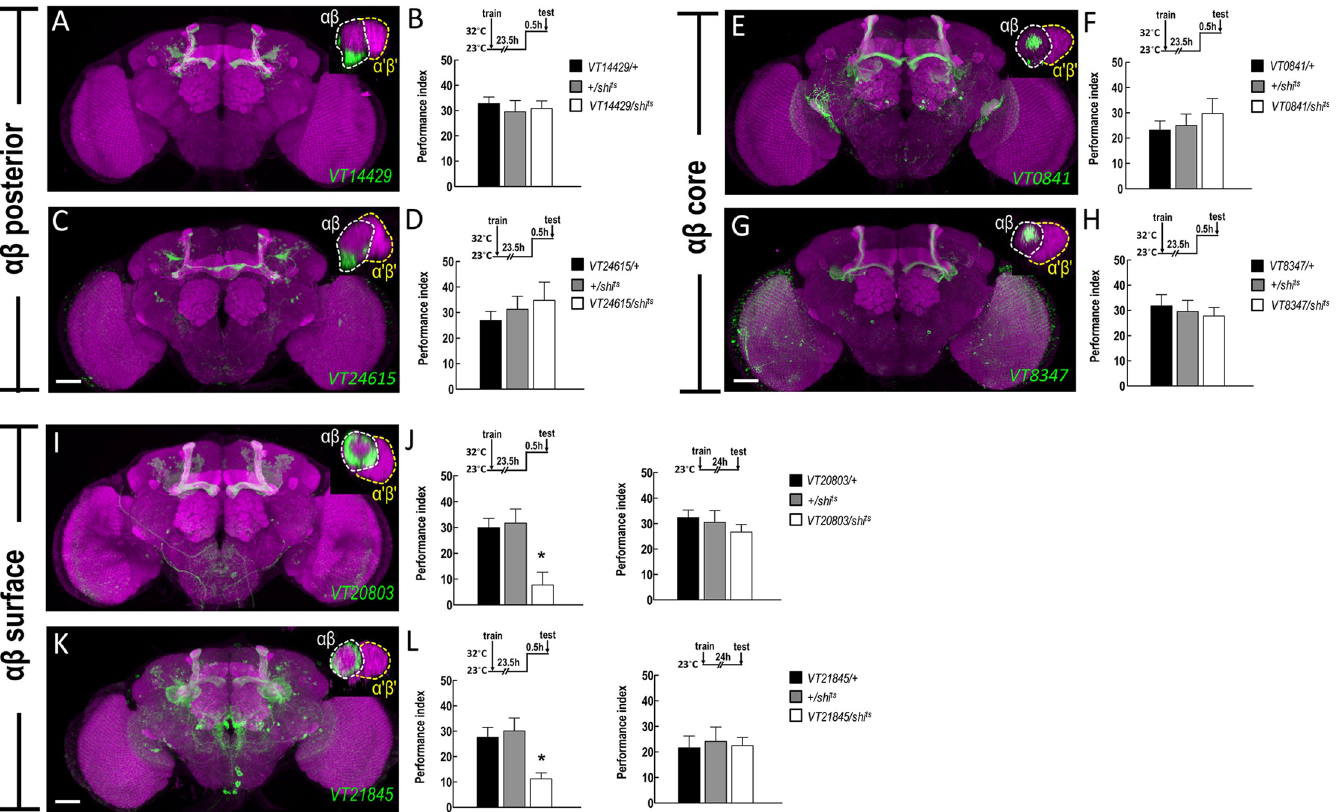
Fig 3. Retrieval of wLTM requires neurotransmission from αβ surface neurons. (A) The expression pattern of VT14429-GAL4 and the high-magnification signal from the horizontal confocal cross section of the MB vertical lobe (top right inset). (B) Blocking neurotransmission from αβ posterior neurons ( VT14429-GAL4 ) using shi ts during retrieval did not affect the 24-hour water-reward memory. Each value represents mean ± SEM (N = 8). p > 0.05; one-way ANOVA. (C) The expression pattern of VT24615-GAL4 and the high-magnification signal from the horizontal confocal cross section of the MB vertical lobe (top right inset). The brain neuropils were immunostained with anti-discs large (DLG) antibody (magenta). Scale bar represents 50 μ m. (D) Blocking neurotransmission from αβ posterior neurons ( VT24615-GAL4 ) using shi ts during retrieval did not affect the 24-hour water-reward memory. Each value represents mean ± SEM (N = 8). p > 0.05; one-way ANOVA. (E) The expression pattern of VT0841-GAL4 and the high-magnification signal from the horizontal confocal cross section of the MB vertical lobe (top right inset). (F) Blocking neurotransmission from αβ core neurons ( VT0841-GAL4 ) using shi ts during retrieval did not affect the 24-hour water-reward memory. Each value represents mean ± SEM (N = 8). p > 0.05; one-way ANOVA. (G) The expression pattern of VT8347-GAL4 and the high-magnification signal from the horizontal confocal cross section of the MB vertical lobe (top right inset). The brain neuropils were immunostained with anti-DLG antibody (magenta). Scale bar represents 50 μ m. (H) Blocking neurotransmission from αβ core neurons ( VT8347-GAL4 ) using shi ts during retrieval did not affect the 24-hour water-reward memory. Each value represents mean ± SEM (N = 8). p > 0.05; one-way ANOVA. (I) The expression pattern of VT20803-GAL4 and the high-magnification signal from the horizontal confocal cross section of the MB vertical lobe (top right inset). (J) Blocking neurotransmission from αβ surface neurons ( VT20803-GAL4 ) using shi ts during retrieval disrupted the 24-hour water-reward memory (left panel). Each value represents mean ± SEM (N = 7). � , p < 0.05; one-way ANOVA followed by Tukey’s test. The 24-hour water- reward memory was normal in VT20803-GAL4 > UAS-shi ts flies as compared to their internal control groups in 23˚C (right panel). Each value represents mean ± SEM (N = 6). p > 0.05; one-way ANOVA. (K) The expression pattern of VT21845-GAL4 and the high-magnification signal from the horizontal confocal cross section of the MB vertical lobe (top right inset). The brain neuropils were immunostained with anti-DLG antibody (magenta). Scale bar represents 50 μ m. (L) Blocking neurotransmission from αβ surface neurons ( VT21845-GAL4 ) using shi ts during retrieval disrupted the 24-hour water-reward memory (left panel). Each value represents mean ± SEM (N = 8). � , p < 0.05; one-way ANOVA followed by Tukey’s test. The 24-hour water-reward memory was normal in VT21845-GAL4 > UAS-shi ts flies as compared to their internal control groups in 23˚C (right panel). Each value represents mean ± SEM (N = 8). p > 0.05; one-way